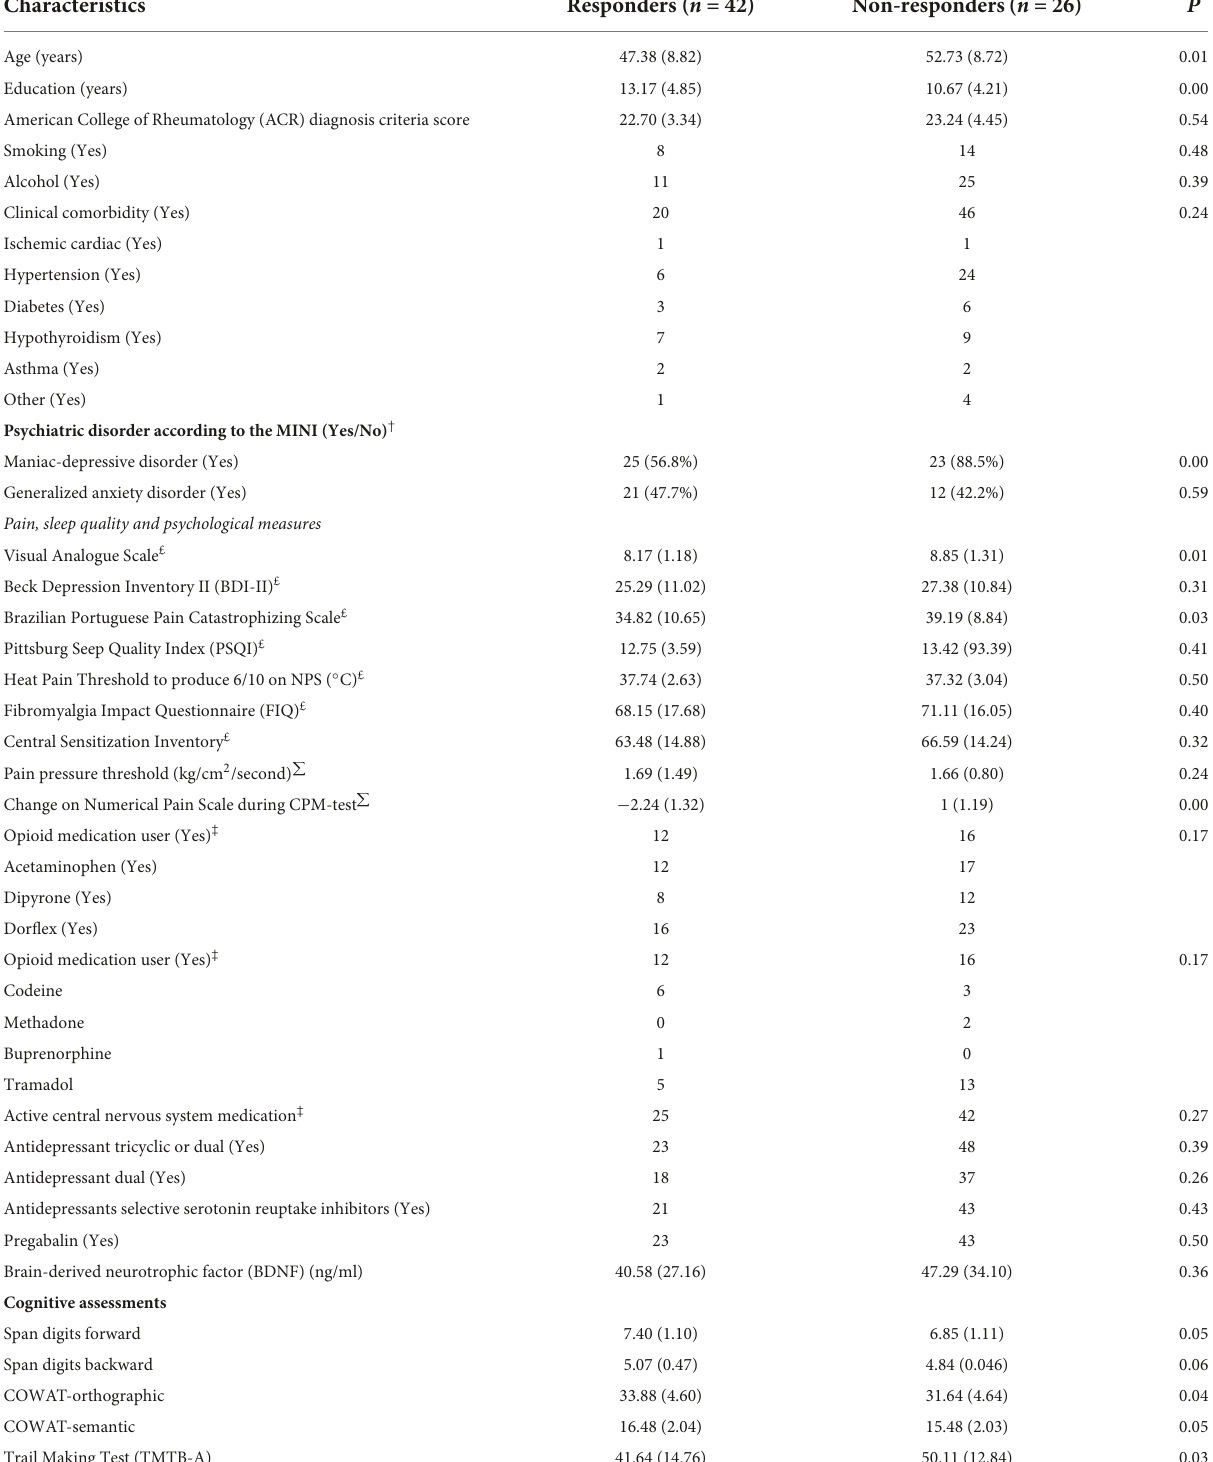
TABLE 4 Demographic and clinical characteristics of the study sample of FM patients.